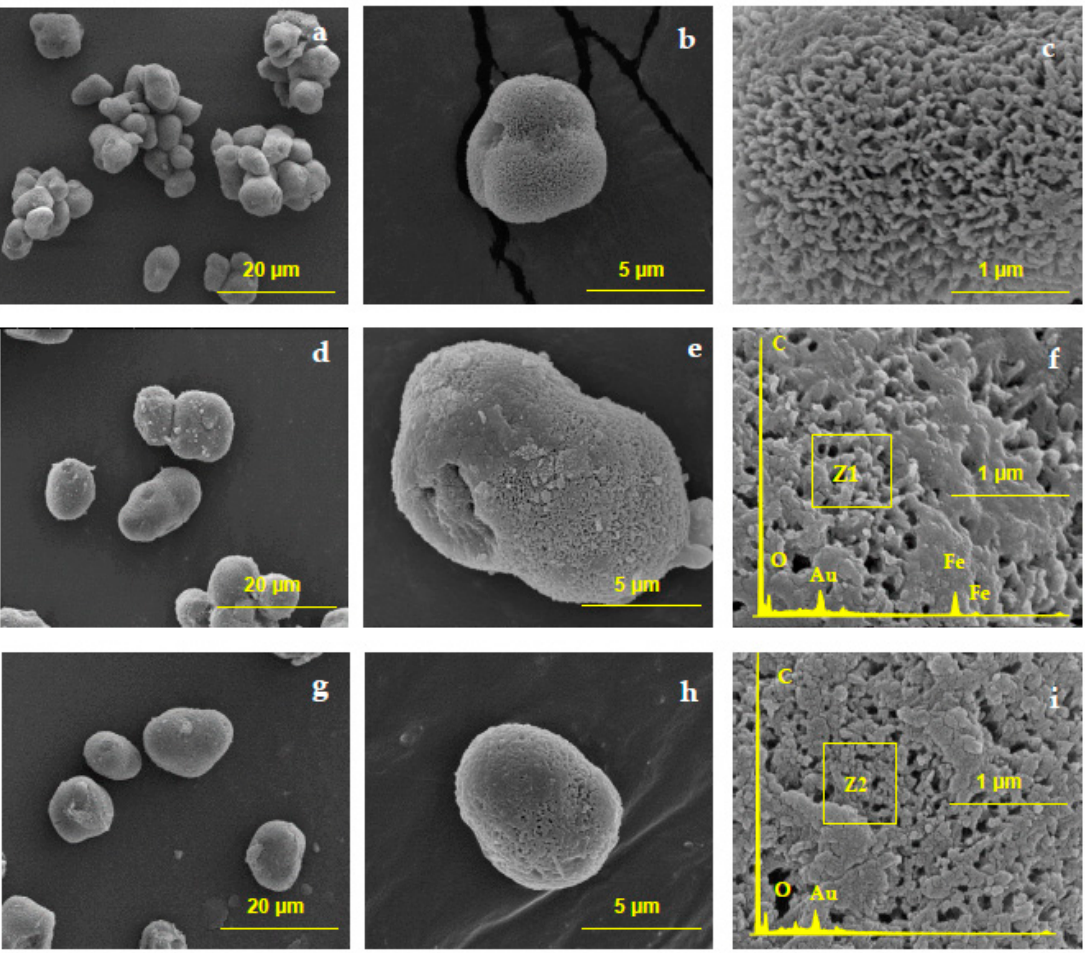
Figure 1. SEM images of empty PA4 particulate supports: ( a – c ) PA4; ( d – f ) PA4-Fe; ( g – i ) PA4-Fe 3 O 4